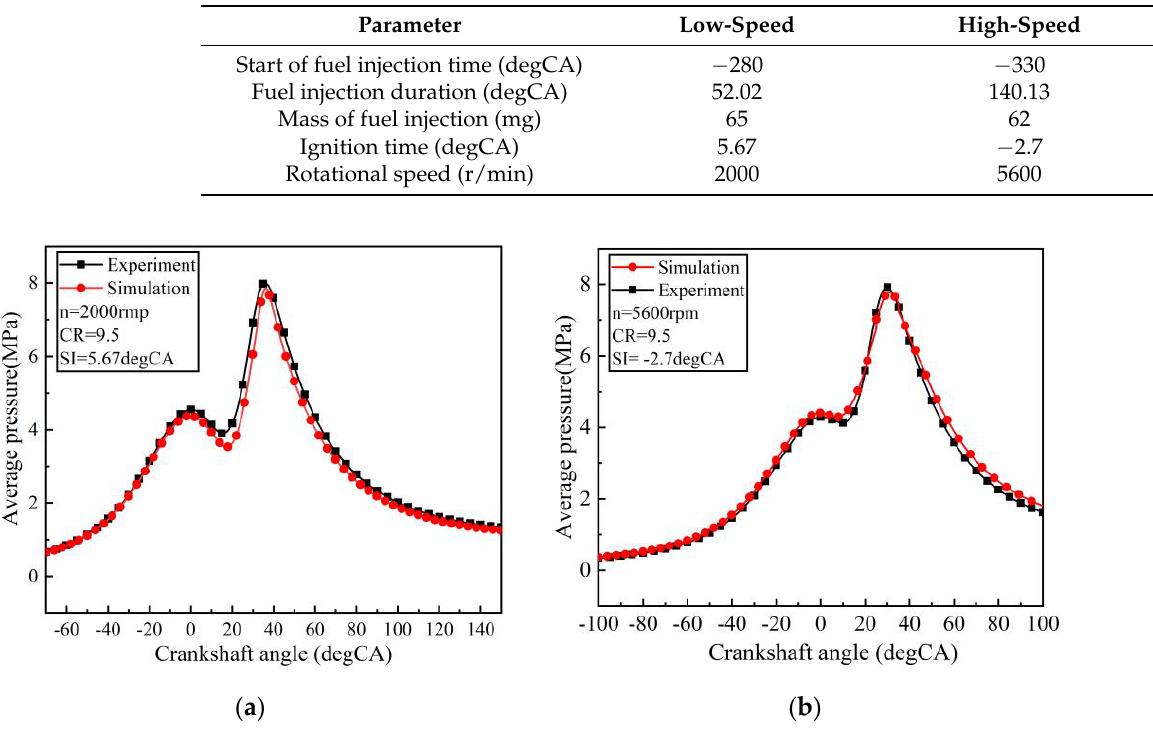
Figure 3. Pressure comparison of experimental results and numerical simulation results at ( a ) 2000 rpm ( b ) 5600 rpm.